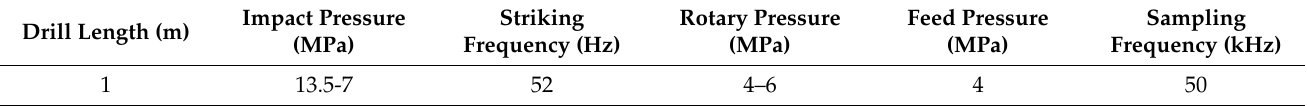
Table 2. Parameters of the experiment.